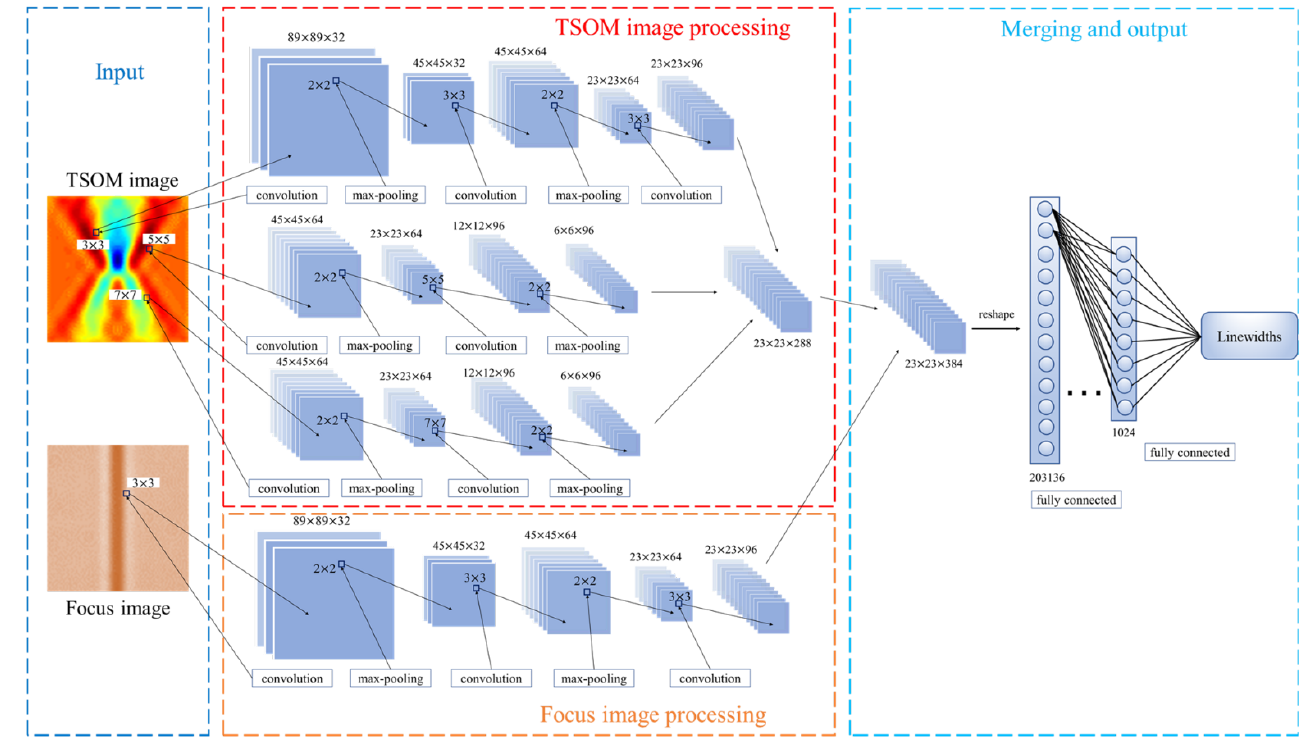
Figure 10. The structure of the two-input CNN for TSOM measurement (Focus & TSOM-CNN). The left area of the network mainly contains the input layer, which is used to input the TSOM images and the focused images into the network. The two kinds of images are 89 × 89 pixels in